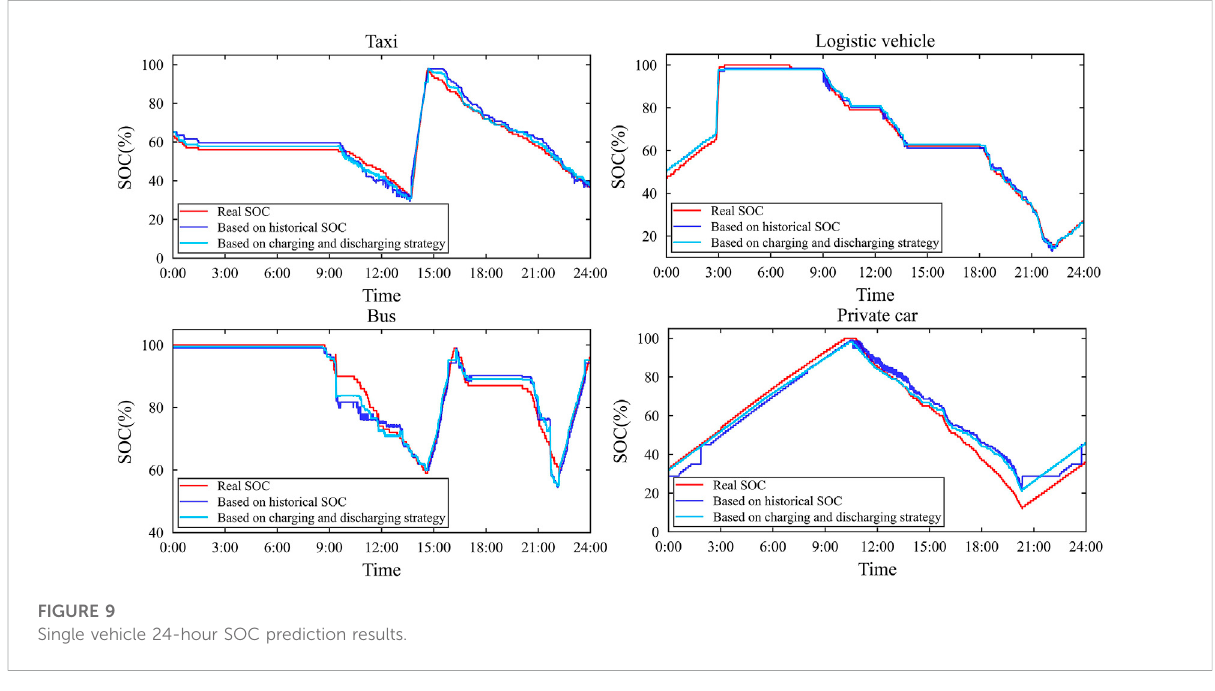
FIGURE 9 Single vehicle 24-hour SOC prediction results.